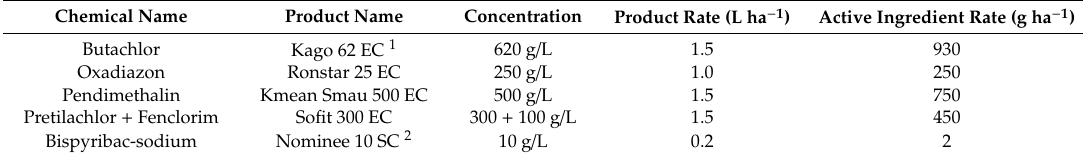
Table 1. Herbicides and rates of